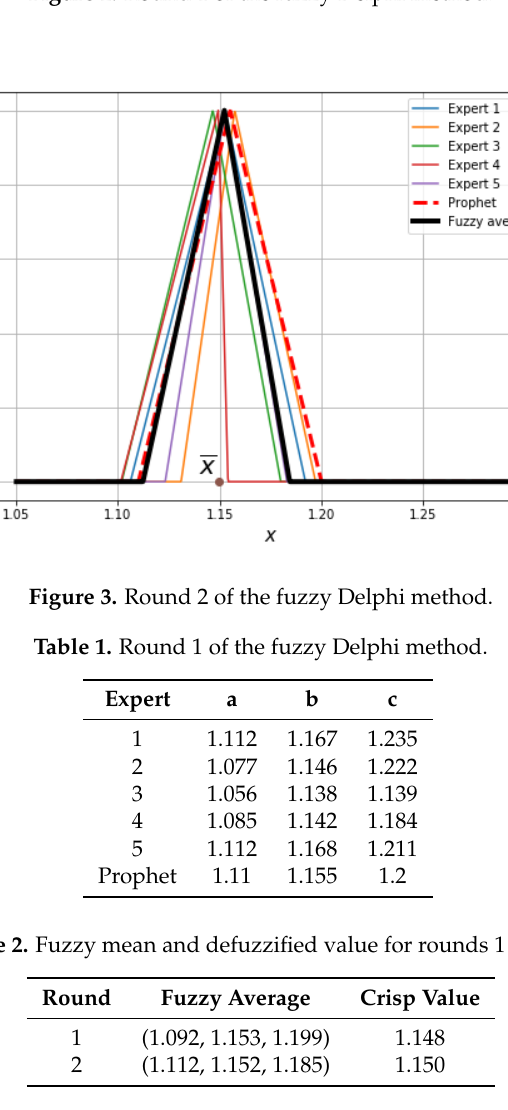
Figure 2. Round 1 of the fuzzy Delphi method.